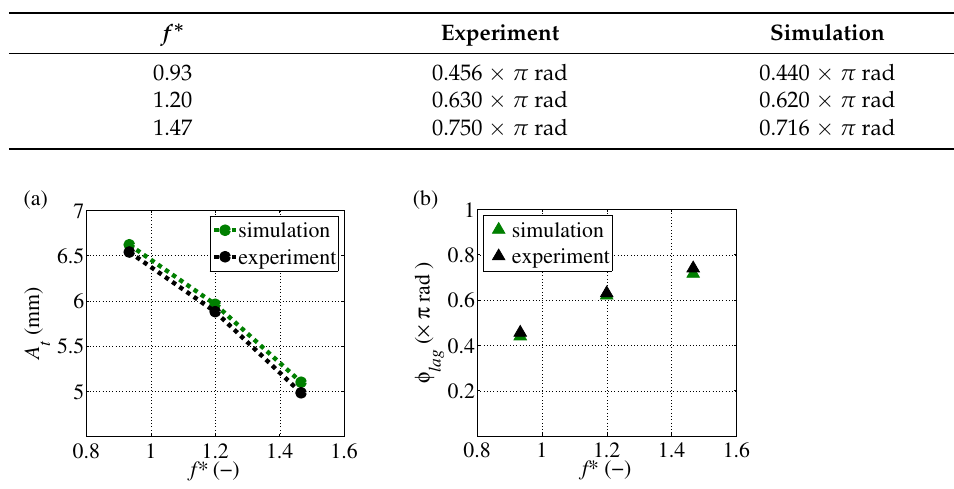
Table 2. Results of phase lag φ lag .